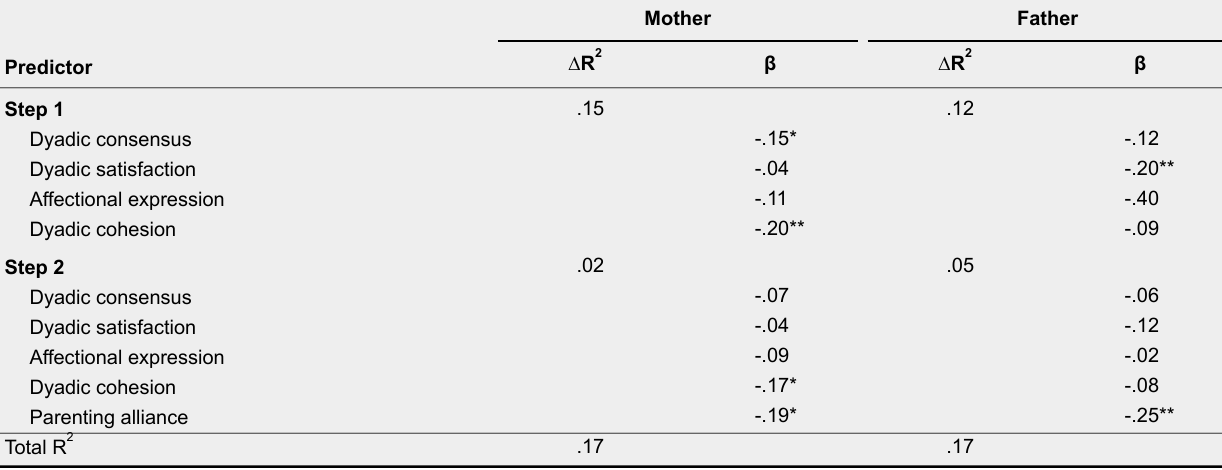
Hierarchical Regression Analysis Predicting Parenting Stress in Mothers (N = 236) and Fathers (N = 236)